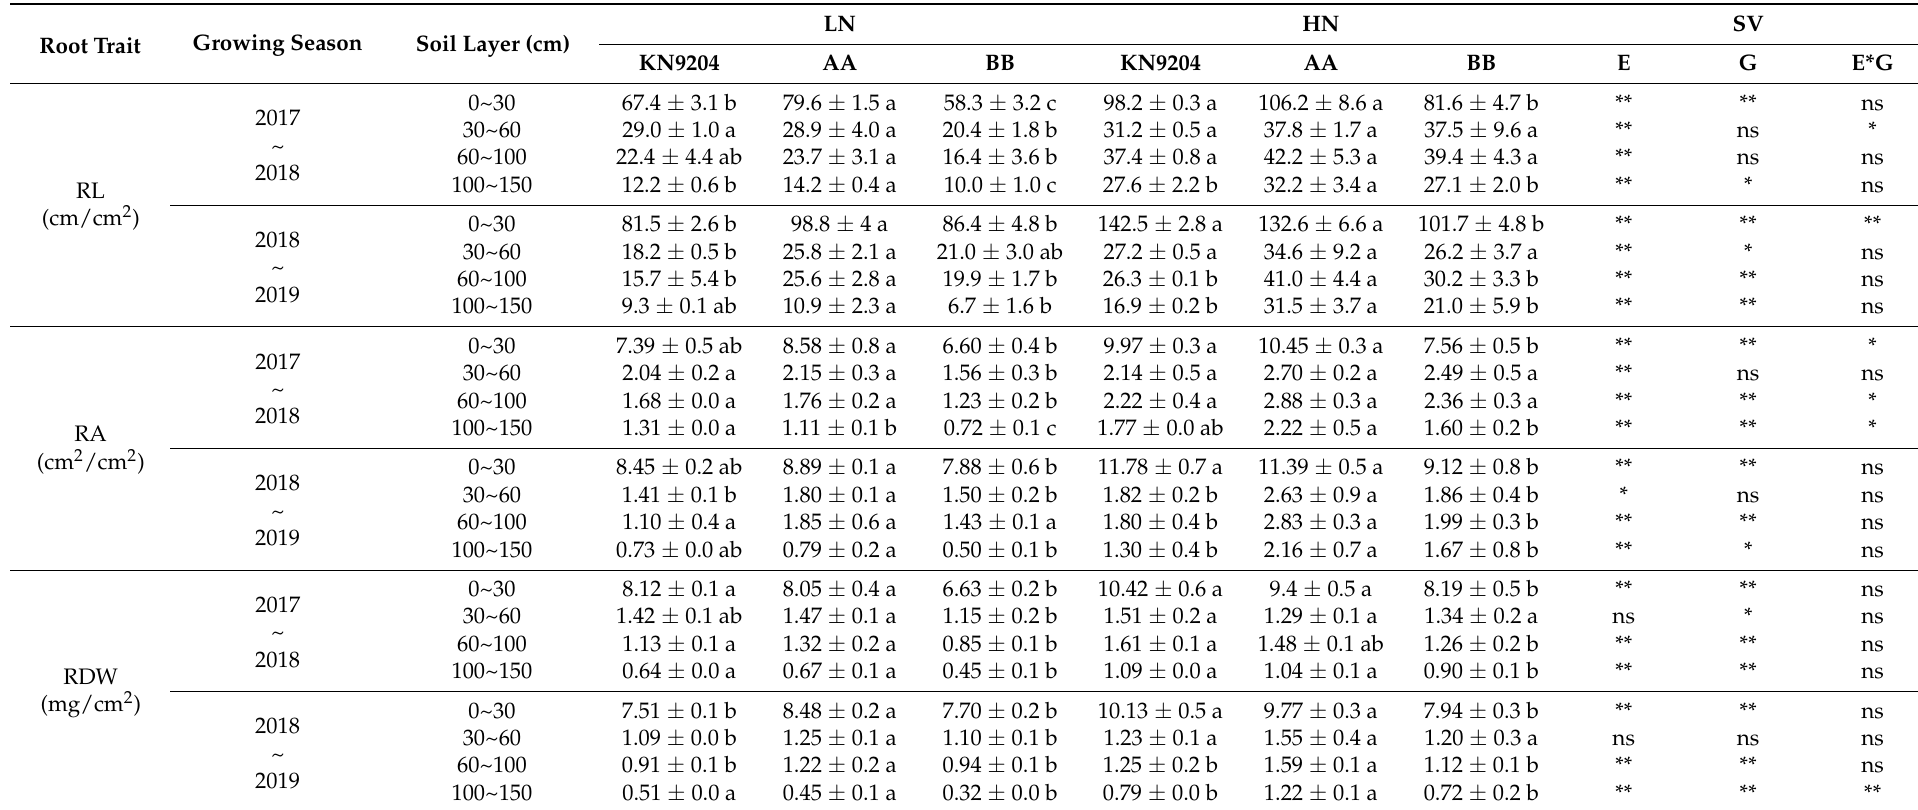
Table 2. The root traits of KN9204 and the QMrl - 7B NILs in different soil layers at 10 days post